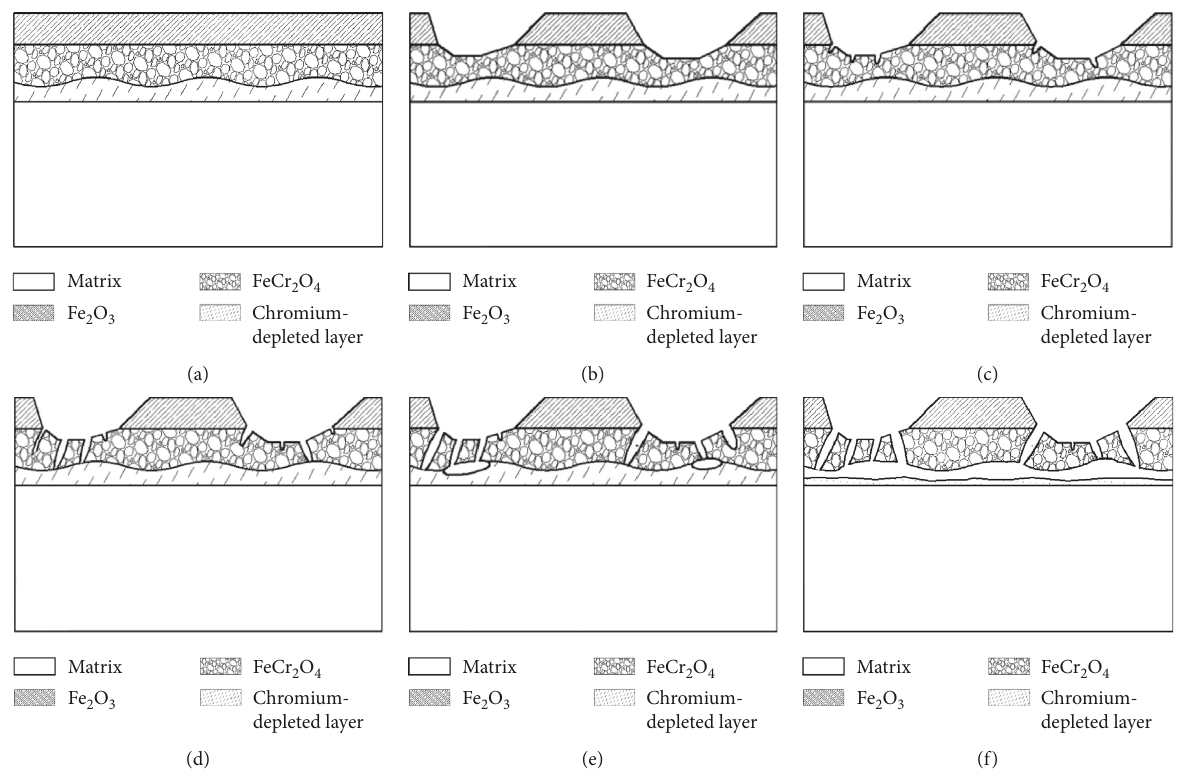
Figure 5: Schematics of the pickling process for oxidized 2205: (a) annealing; (b) shot blasting; (c) incubation period; (d) pitting period; (e) accelerated period; (f) end of